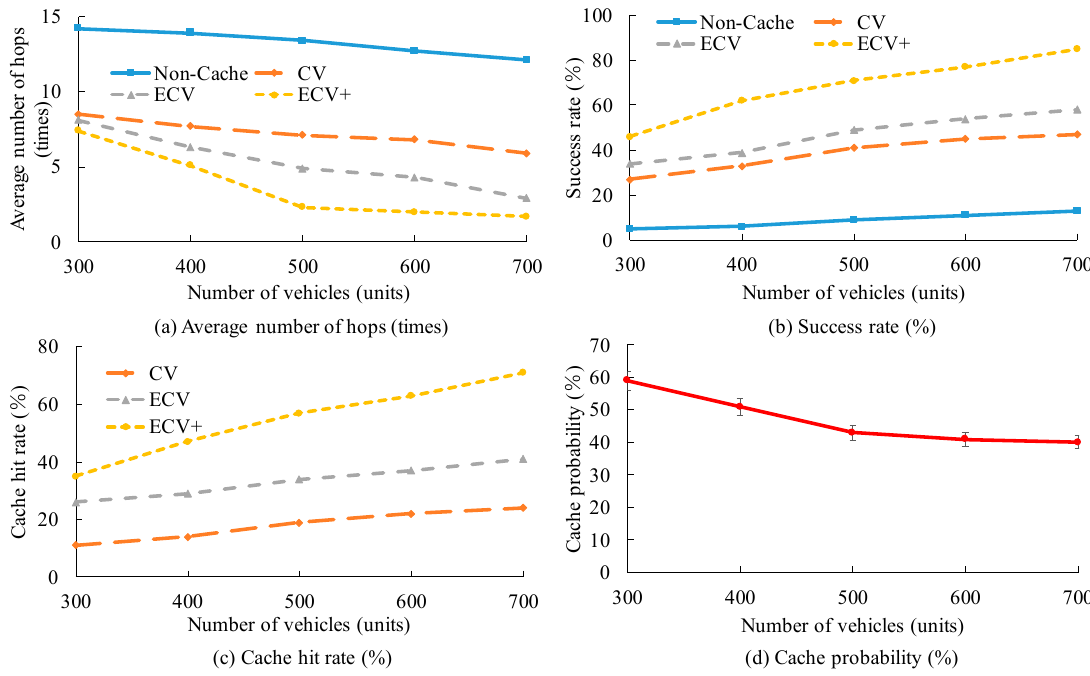
Figure 8. Results under different number of vehicles (cache buffer capacity is 100 GB and information generation interval is 4 s).